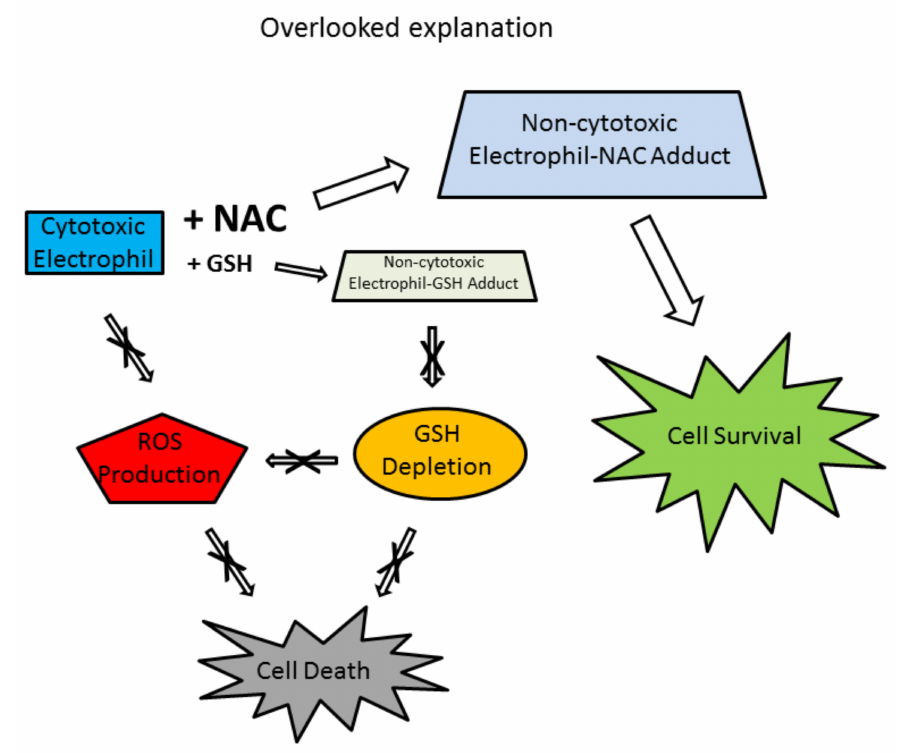
Figure 4. Schematic for the often-overlooked NAC protection mechanism. Electrophiles can directly and quantitatively interact with NAC, which is added in excess, to form a non-cytotoxic electrophile– NAC adduct. This interaction prevents GSH depletion, ROS production, and cell